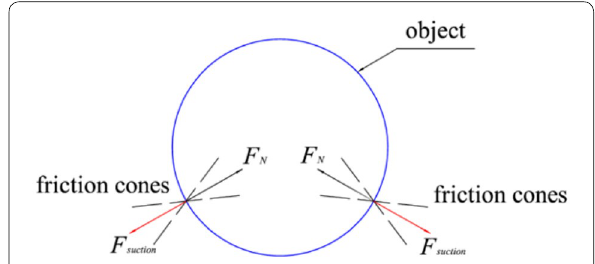
Figure 4 Displaying the force condition of grasping object with